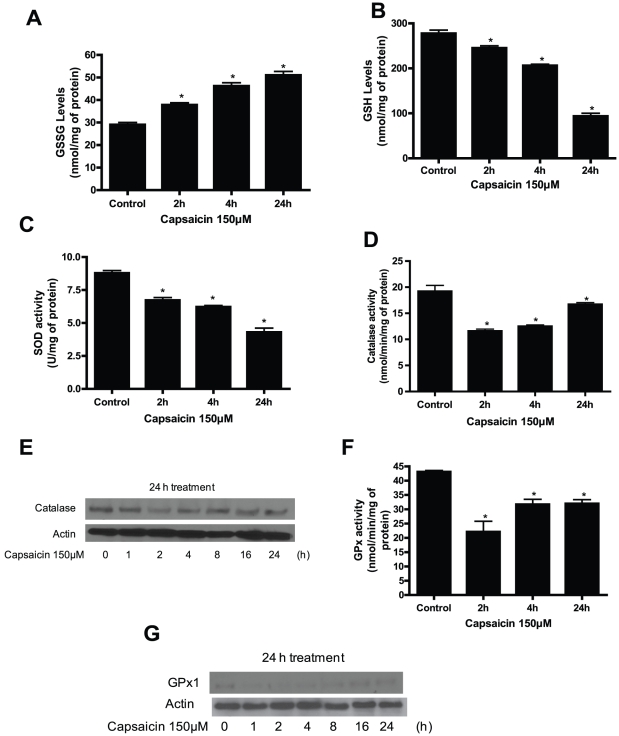
Capsaicin treatment disrupts cellular redox homeostasis resulting in oxidative stress.(A) Effect of capsaicin on the levels of oxidized glutathione (GSSG). BxPC-3 cells were treated with DMSO or 150 µM capsaicin for 2, 4 and 24 h and GSSG and (B) GSH levels were determined using a commercially available kit. These experiments were repeated twice with similar results obtained each time. (C) SOD, (D) Catalase, (F) GPx activities were determined as described in the method section. BxPC-3 cells were treated with DMSO or 150 µM capsaicin for 2, 4 and 24 h. Results are expressed as mean ± SD (n = 3) of three independent experiments. *Statistically different when compared with control (P<0.05) as analyzed by one-way ANOVA followed by Bonferroni's post-hoc test. (E) and (G) Expression of catalase and GPx1 were determined by immunoblotting of BxPC-3 cells treated with DMSO or 150 µM capsaicin for indicated time period. Each blot was stripped and reprobed with anti-actin antibody to ensure equal protein loading. These experiments were performed three times independently and similar results were obtained.